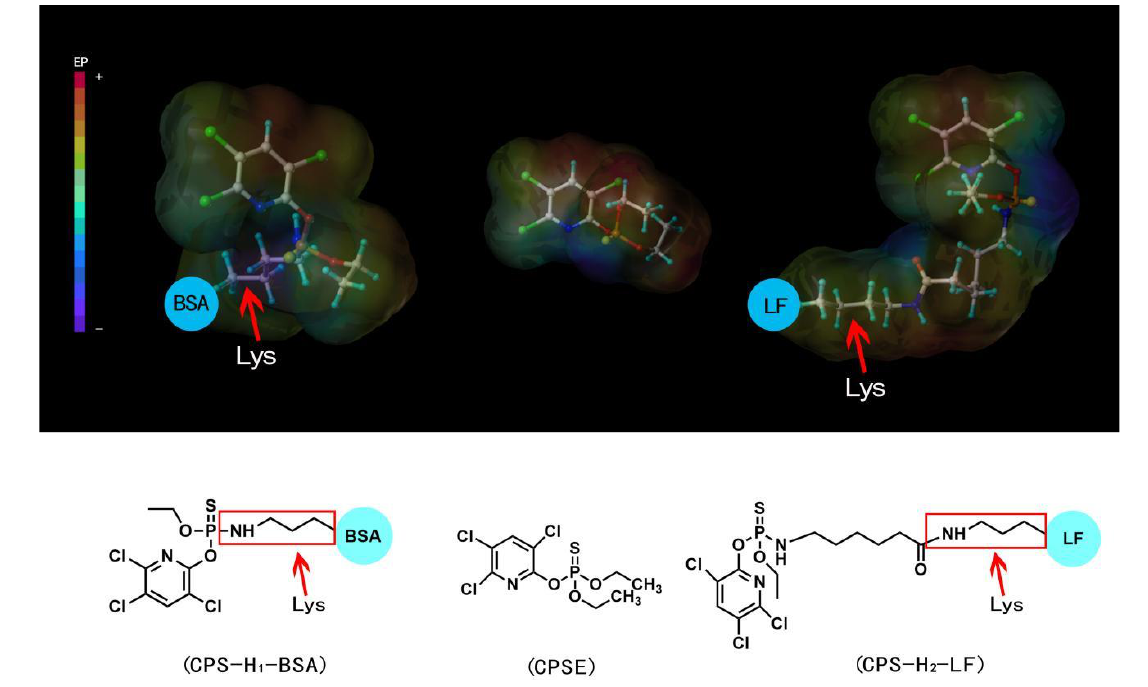
Figure 2. The lowest energy conformations and molecular electrostatic potential isosurfaces of CPSE and haptens.